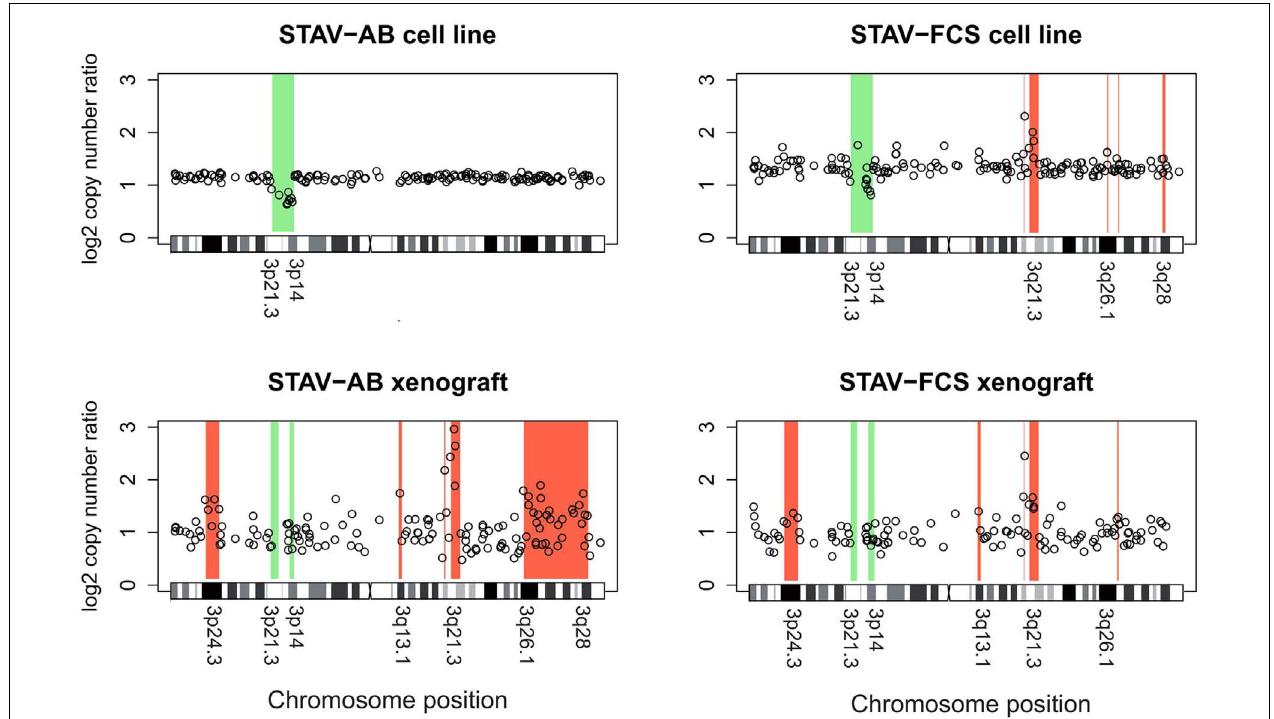
gained in STAV-AB-derived xenografts. Compared to the cell sub-lines, xenografts irrespective of origin were more similar to STAV-FCS cells, suggesting a clonal expansion in the STAV-AB-derived xenografts of cells with genetic similarities to STAV-FCS cells.The variability was greater in xenografts, likely because those specimens were fixed in